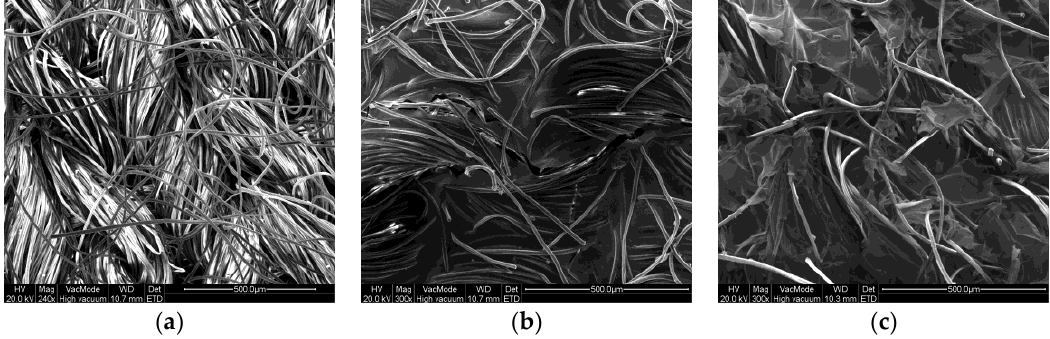
Figure 9. SEM: ( a ) WR treated; ( b ) PEDOT:PSS coated; ( c ) PEDOT:PSS-PDMS:PEO coated.